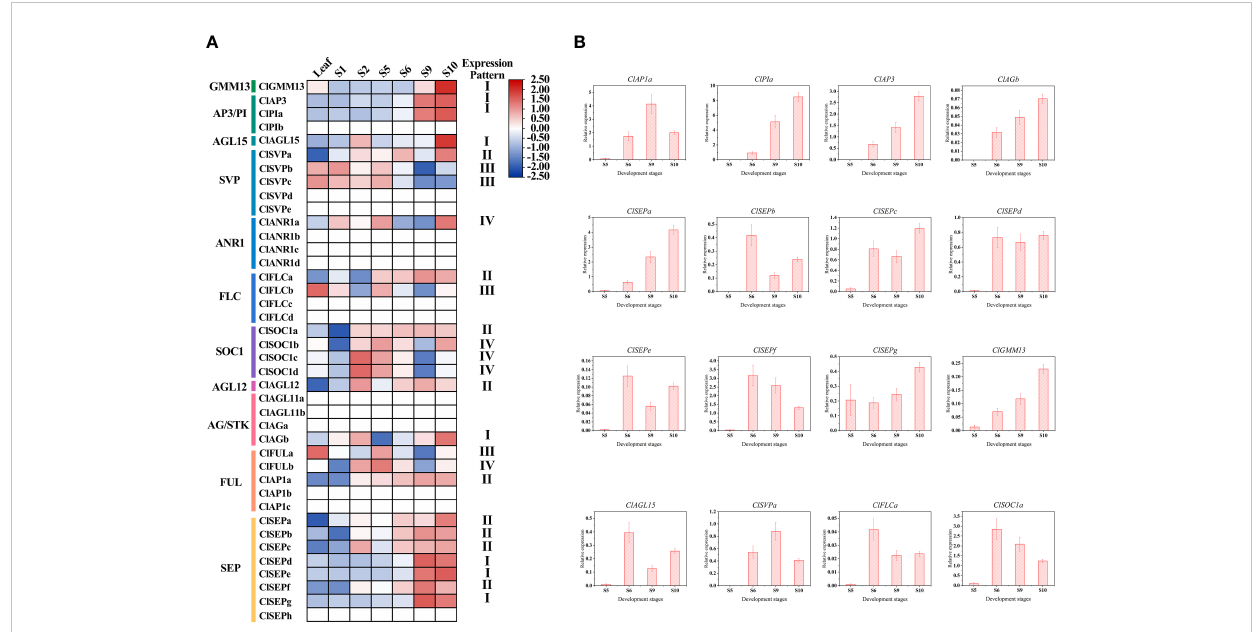
FIGURE 4 Expression pattern of ClMIKCc during the capitulum development stage. (A) Expression heat map constructed based on transcriptome data during the capitulum development stage of C. lavandulifolium . (B) qRT-PCR analysis of the expression level of class I and class II ClMIKCc in four development stages. Error bars represent the standard errors of three biological